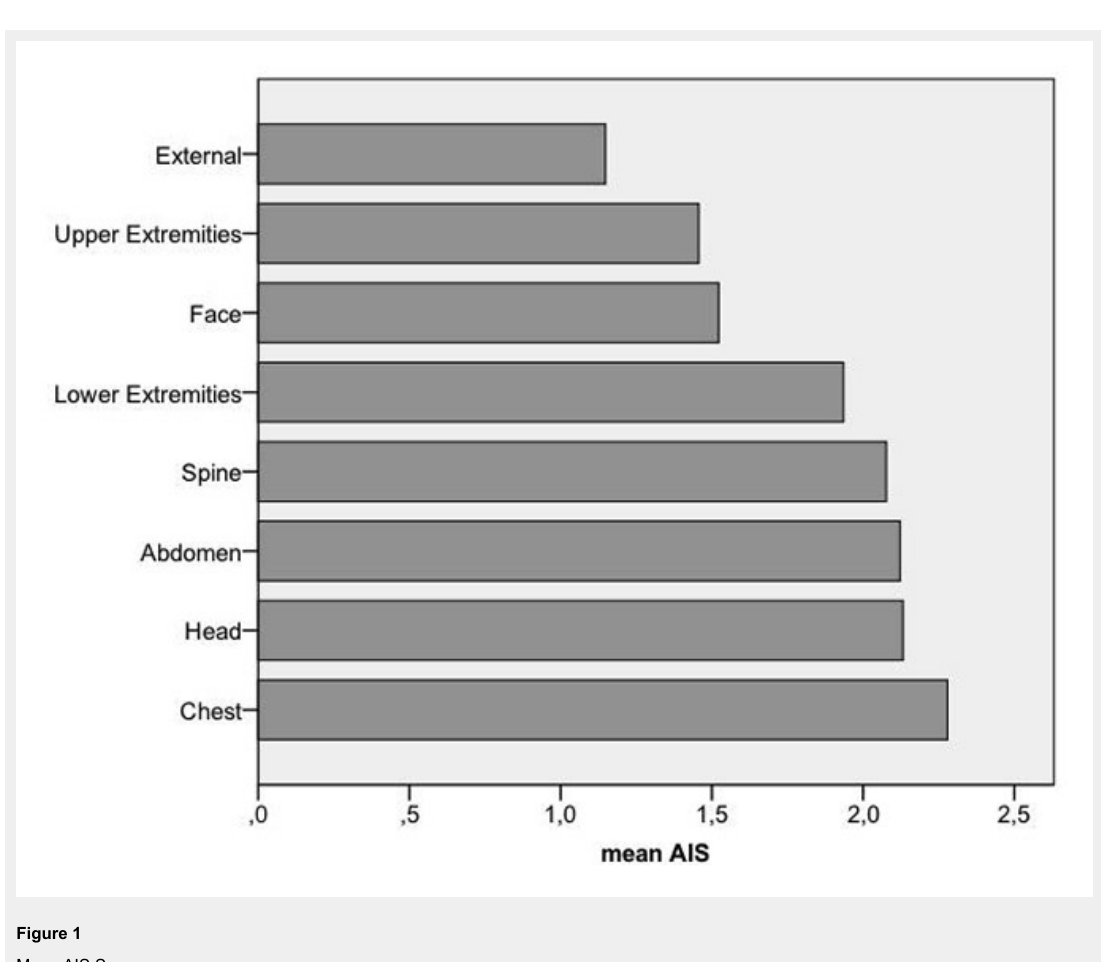
Figure 1 Mean AIS Score. External injuries include soft tissue injuries and